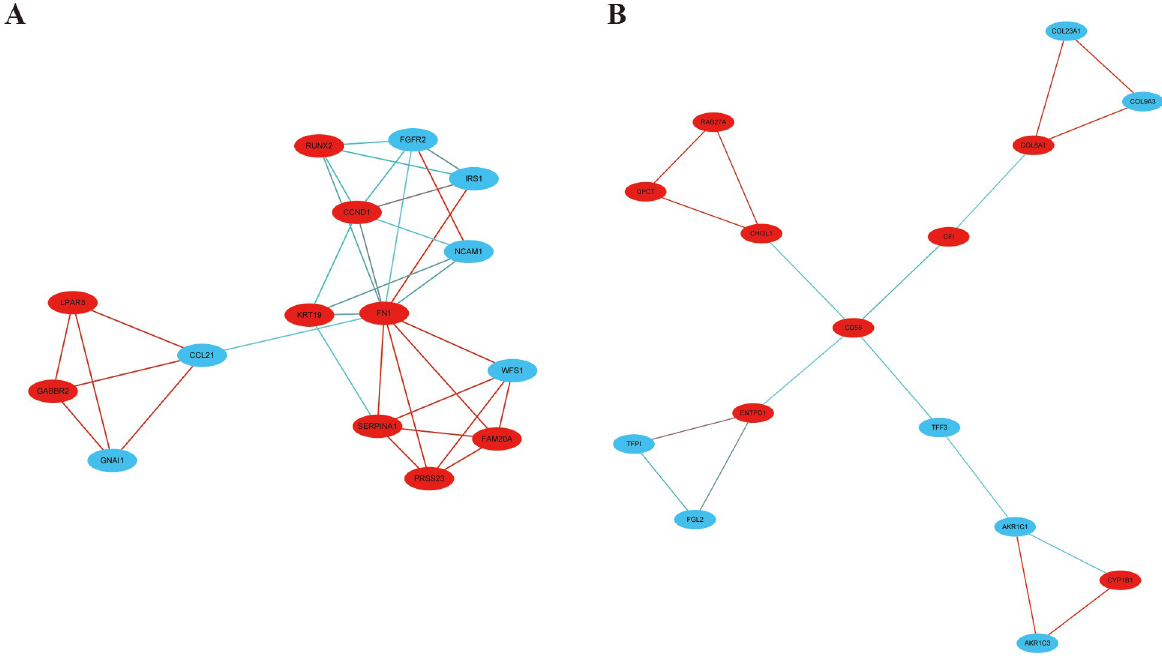
Fig 4. Module analysis by MCODE using Cytoscape. A. module1; B. module2. Red circles represent upregulated DEGs and blue circles denote downregulated DEGs.